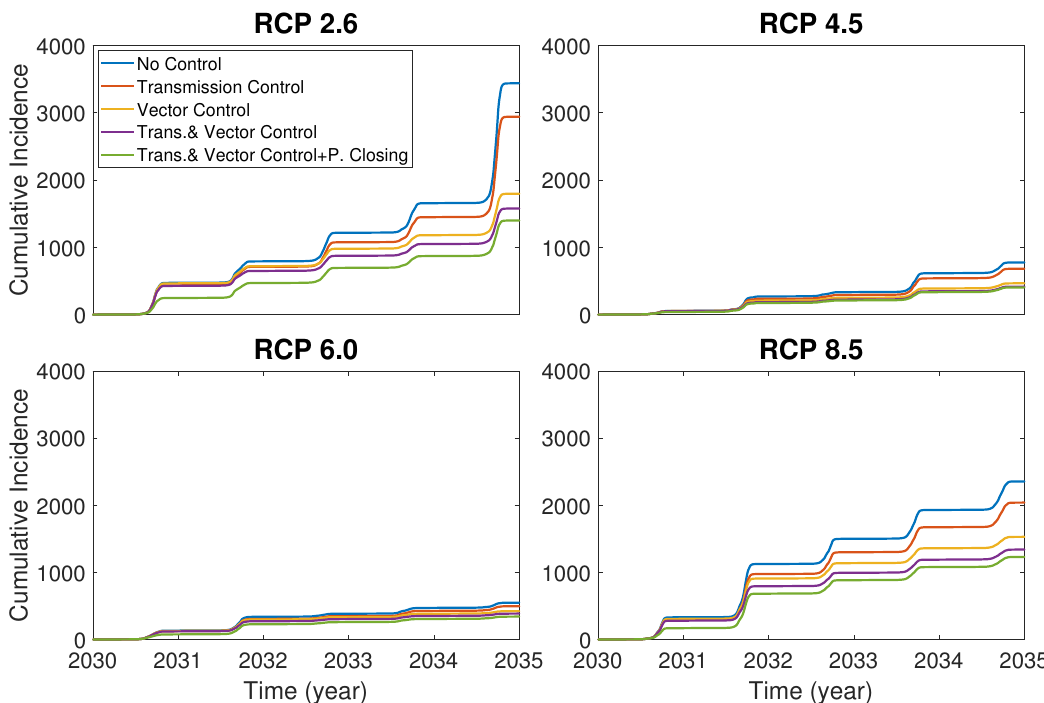
Figure 6. Comparison of cumulative incidences under different control strategies: no control, transmission control, vector (mosquito death) control, combination of transmission and vector controls and combination of transmission control, vector control and park closure.